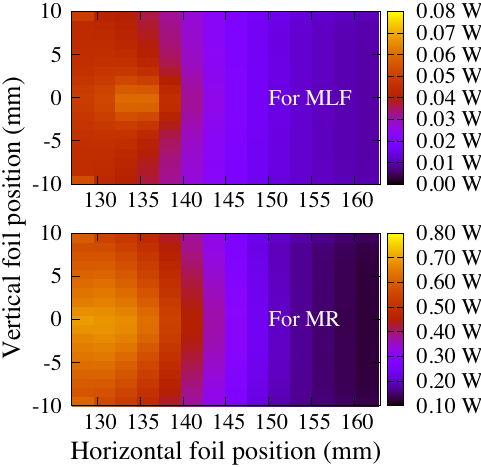
FIG. 4. Power deposition distributions in the foil estimated from the simulated particle hit distributions for the MLF (top) and MR (bottom)